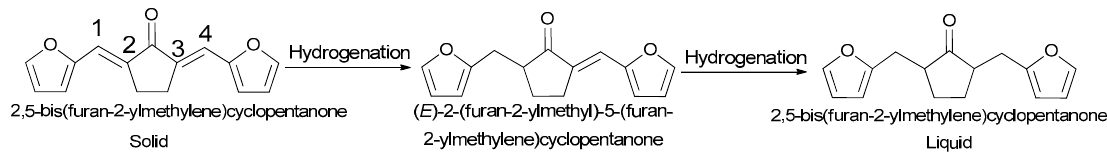
Scheme 2. Synthetic strategies for 2,5-bis(furan-2-ylmethyl)-cyclopentanone from 2,5-bis(2- furylmethylde ne)-cyclopentanone hydrogenation [47].